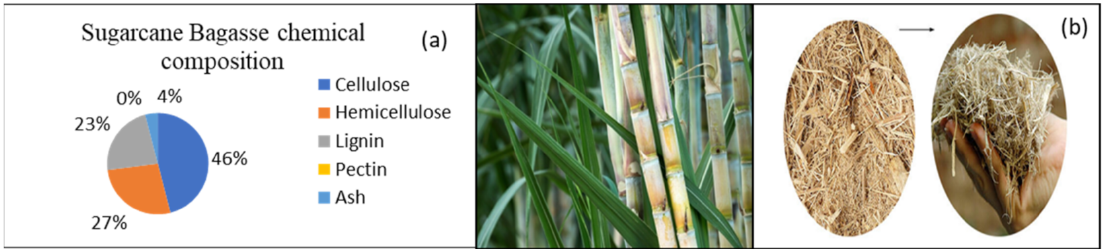
Figure 29. ( a ) Sugarcane bagasse chemical composition and ( b ) sugarcane and